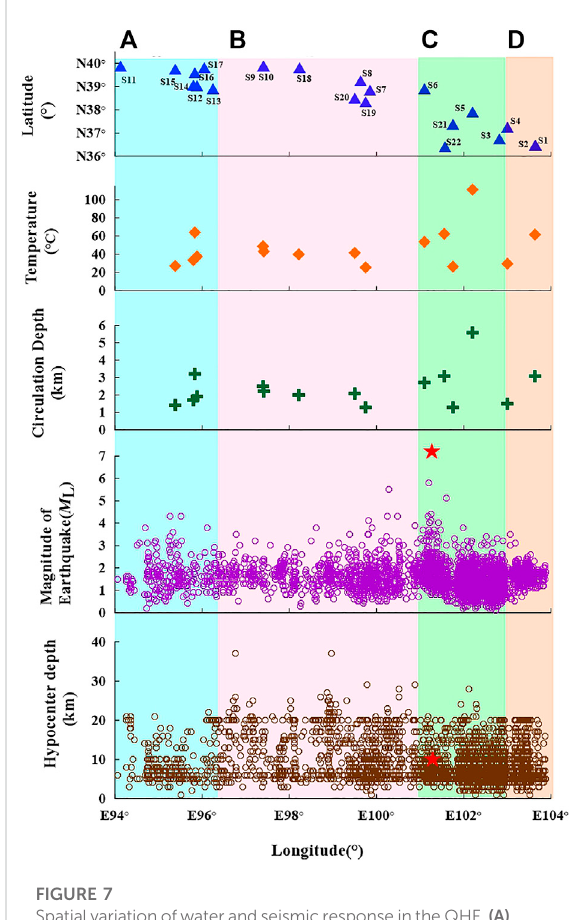
FIGURE 7 SpatialvariationofwaterandseismicresponseintheQHF. (A) Subei segment; (B) Jiayuguan – Zhangye segment; (C) Wuwei – Tianzhu segment; (D) Lanzhou segment. The red star is the M s 6.9 Menyuan earthquake. The duration of the earthquake data is from January 2019 to January 2022. The temperature values plotted here are estimated values by the application of the quartz